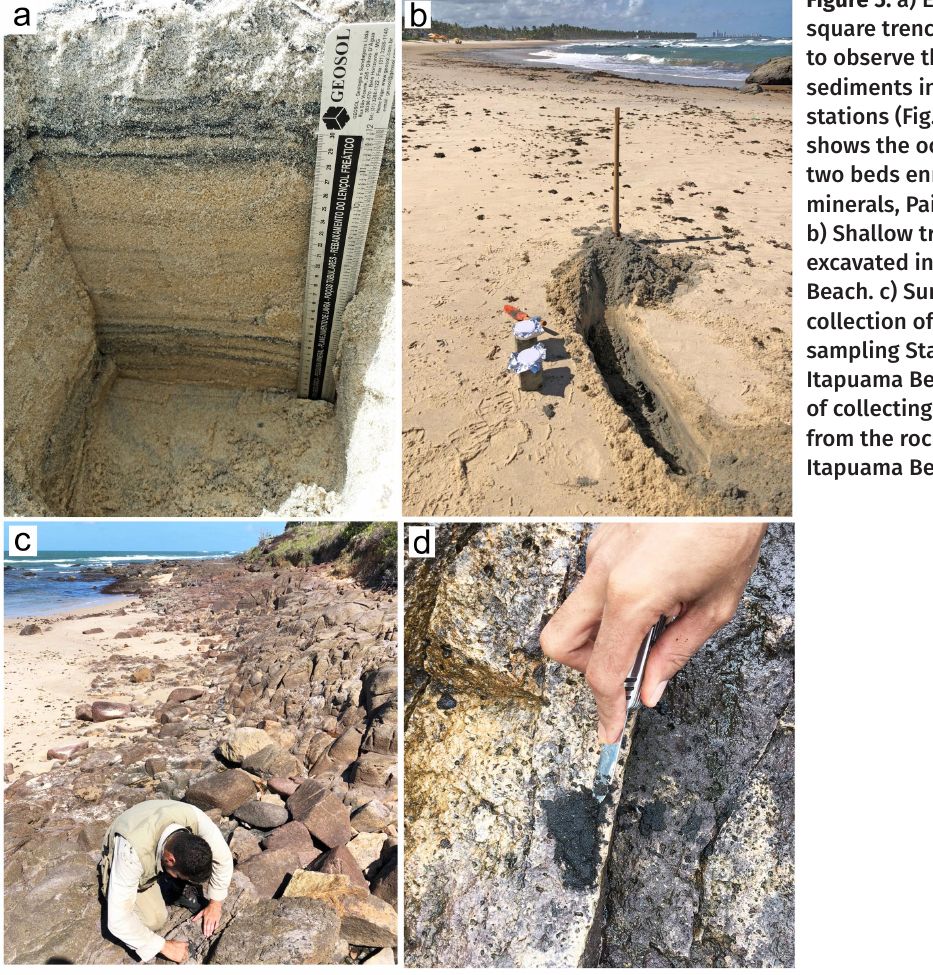
Figure 5. a) Example of